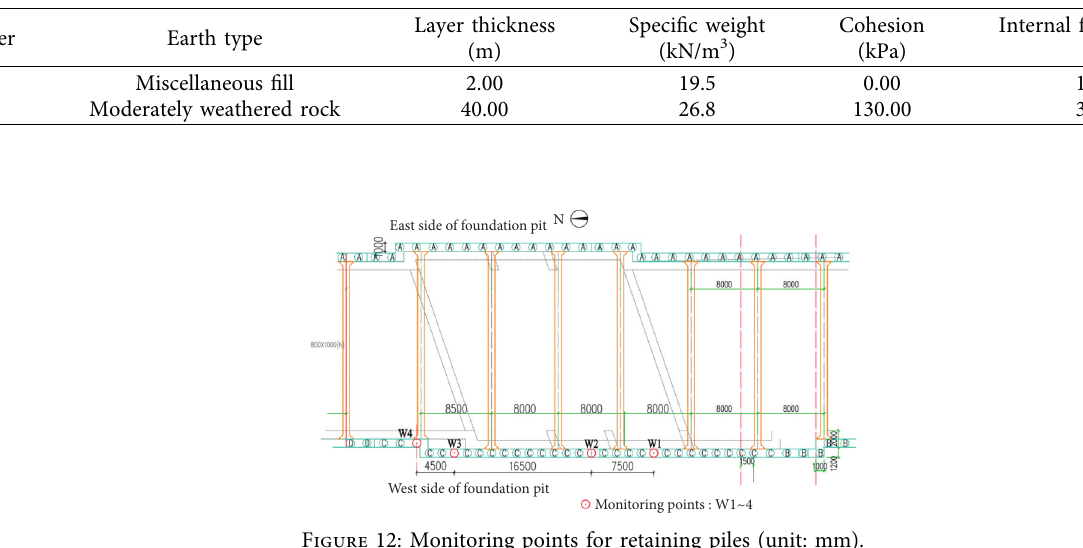
Table 3: Geotechnical parameters of the earth.